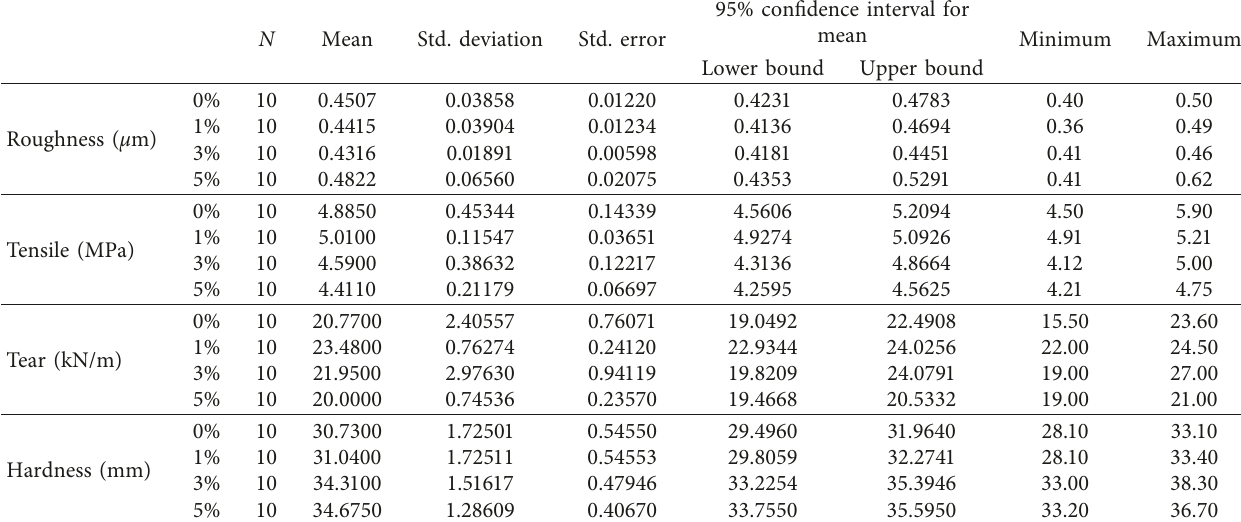
Table 1: Descriptive statistics and one-way analysis of variance (ANOVA) for hardness, tear strength, tensile strength, and roughness. N Mean Std.